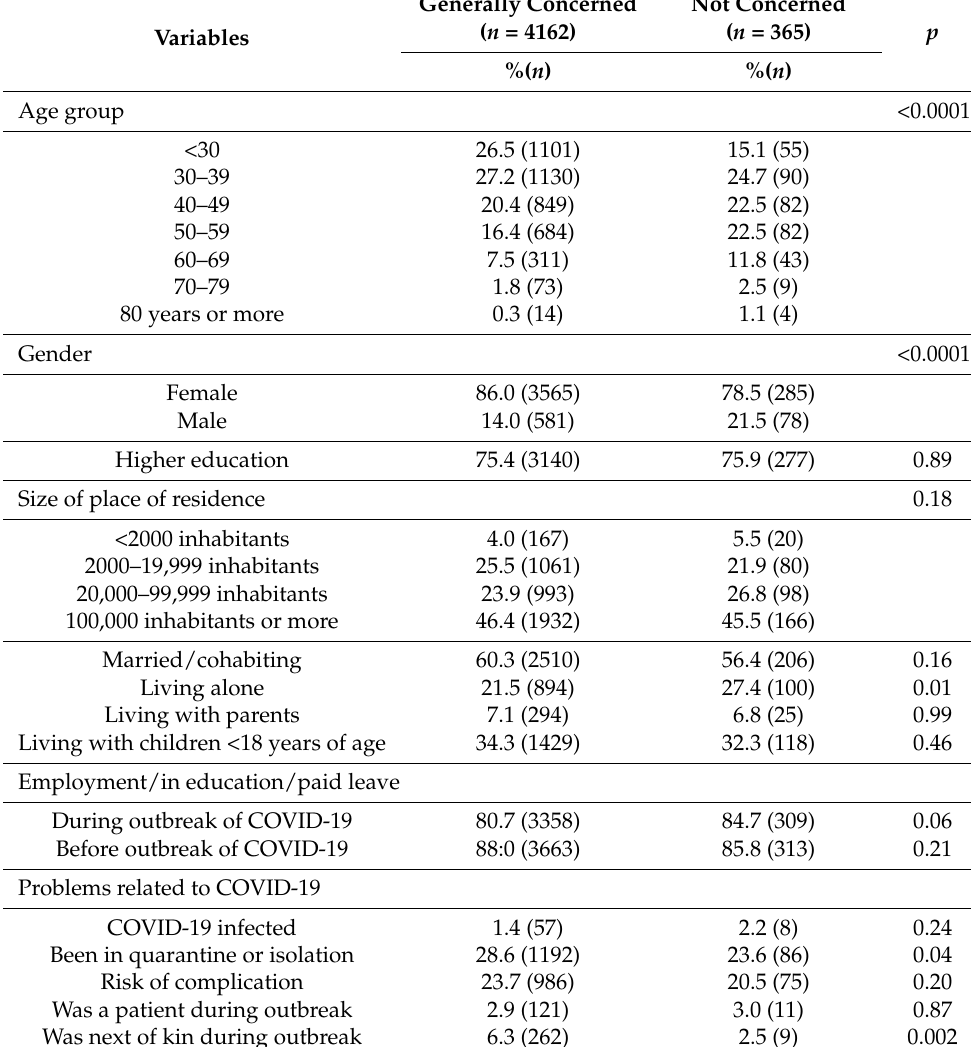
Table 1. Sample characteristics ( n =